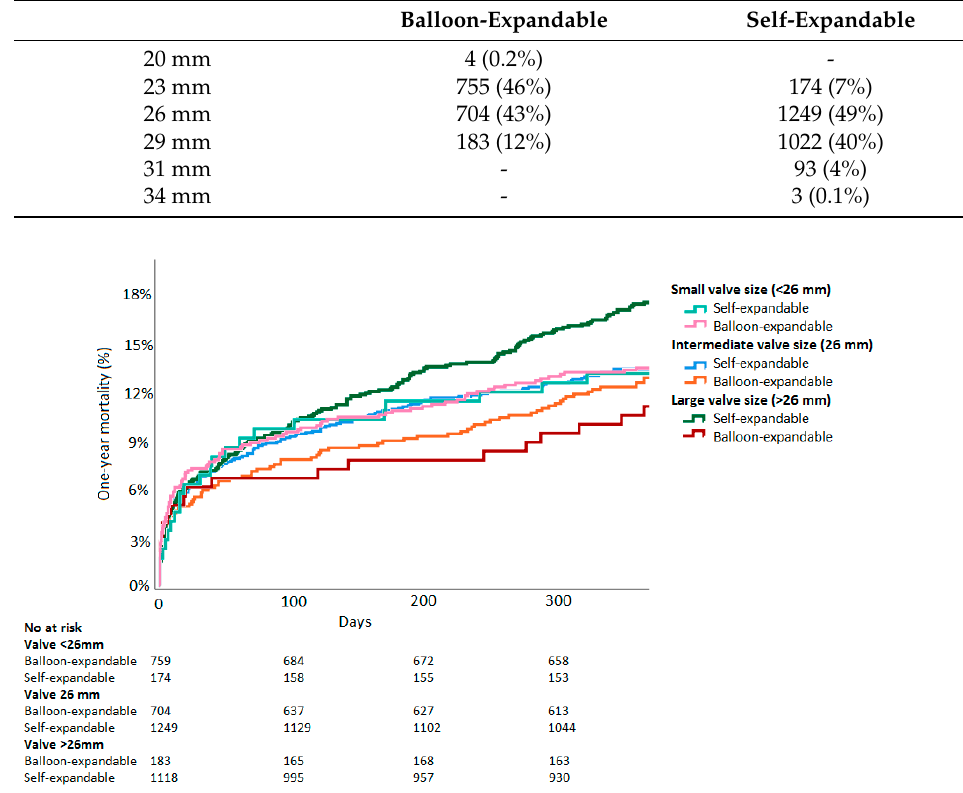
Figure 3. Time-to-event Kaplan–Meier all-cause mortality curves of balloon-expandable vs. self-ex- pandable valves split by valve